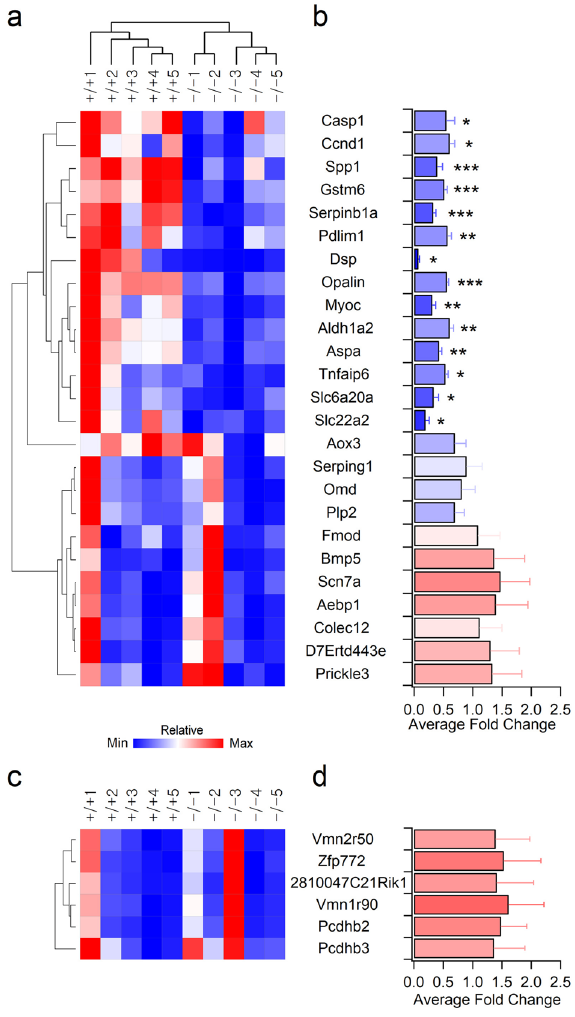
Figure 2. Validation of microarray results by quantitative reverse transcription PCR (qRT-PCR) ( a , b ) qRT- PCR validation of 25 down-regulated genes identified by microarray analysis. ( a ) Genes with similar expression patterns were clustered and visualized by Treeview. ( b ) Average fold changes in expression levels of genes identified as down-regulated genes from microarray analysis were analyzed by qRT-PCR. * p < 0.05; ** p < 0.01; *** p < 0.001 by Student’s t -test, n = 5 pairs. ( c , d ) mRNA expression levels of genes identified as up-regulated genes from microarray analysis were not statistically different between genotypes. Treeview representation ( c ) and average fold changes ( d ) of expression determined by